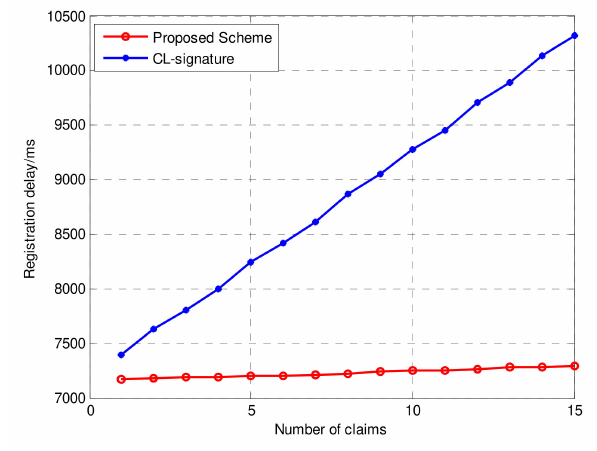
Figure 8. The delay in certificate registration for multiple claims.